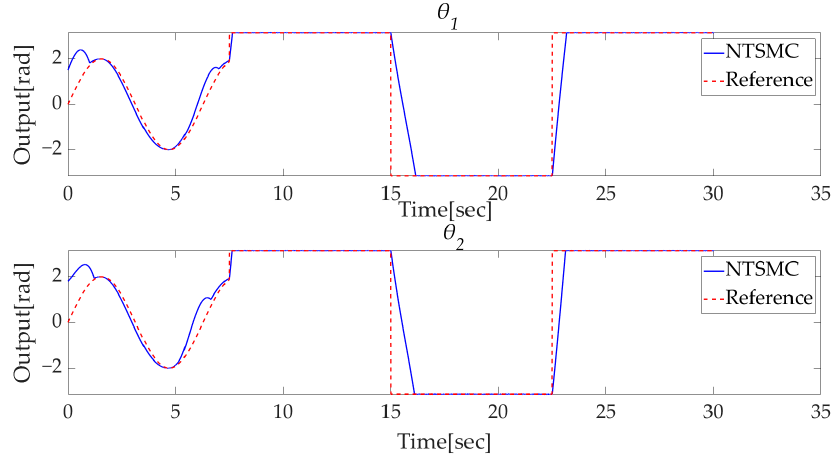
Figure 16. NTSMC controller performance for mixed input.